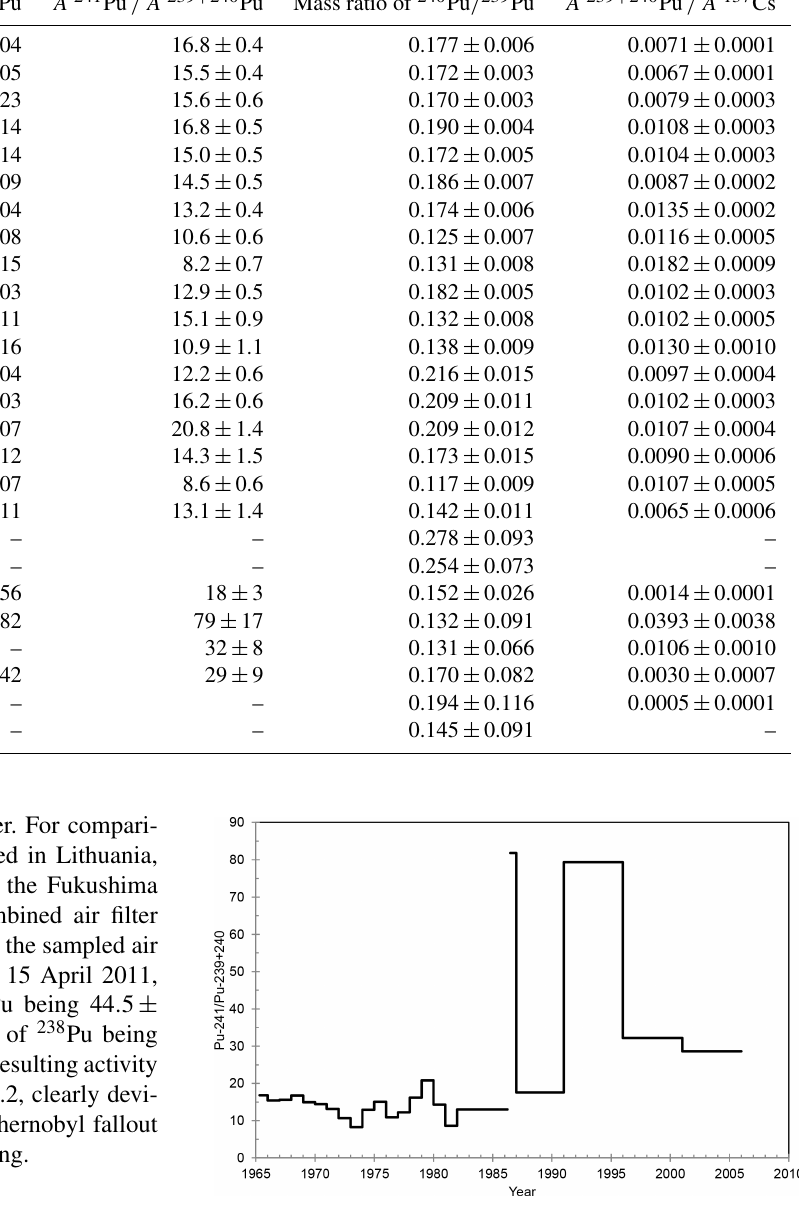
Figure 4. The activity ratio of 241 Pu / 239 + 240 Pu in the surface air of Rovaniemi as a function of